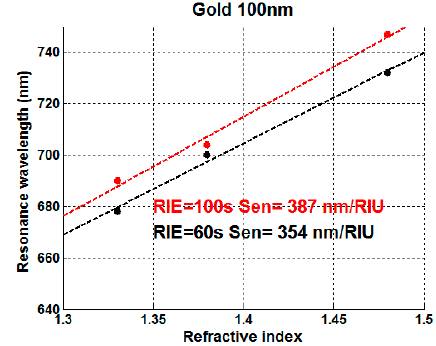
Figure 5. Bulk sensitivity for SPRG sensors. Black: 60 s of RIE etching; Red: 100 s RIE